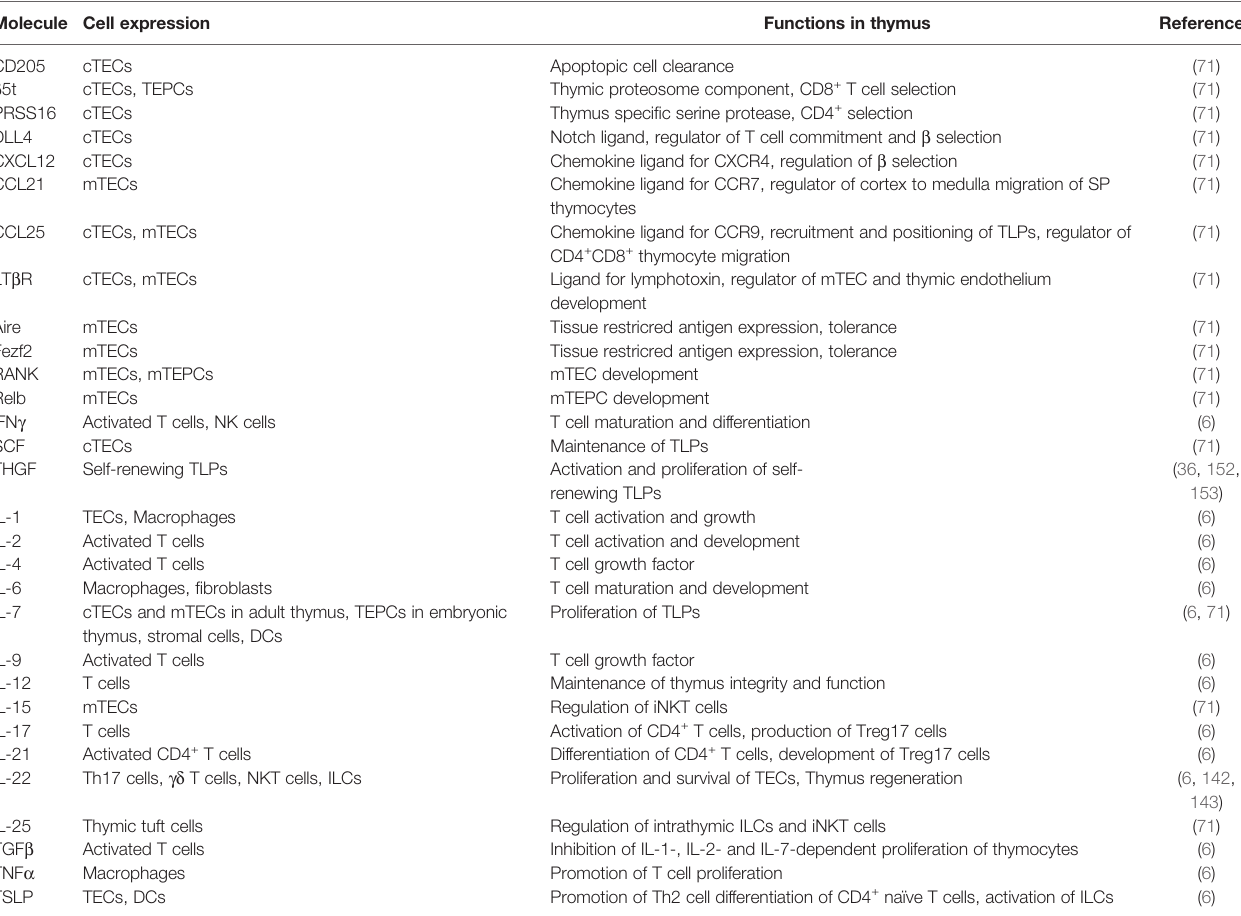
TABLE 1 | Key signaling molecules of intrathymic cellular